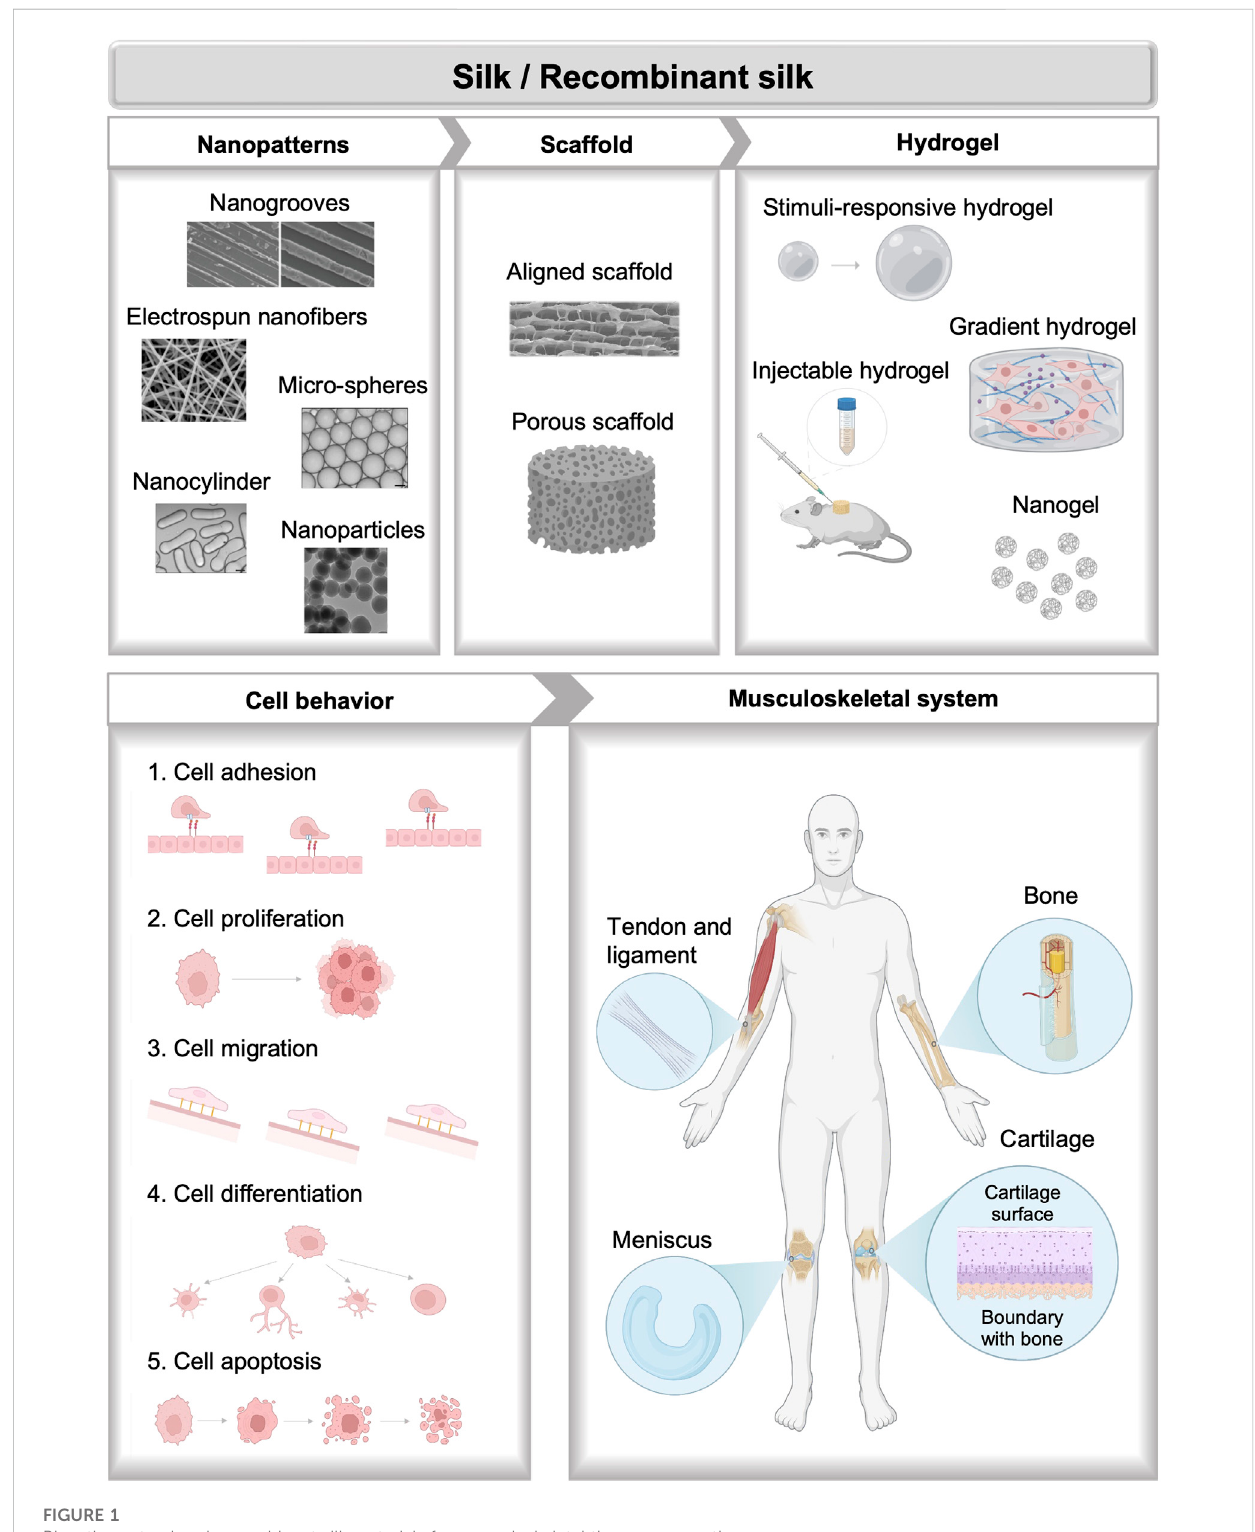
FIGURE 1 Bioactive natural and recombinant silk materials for musculoskeletal tissue